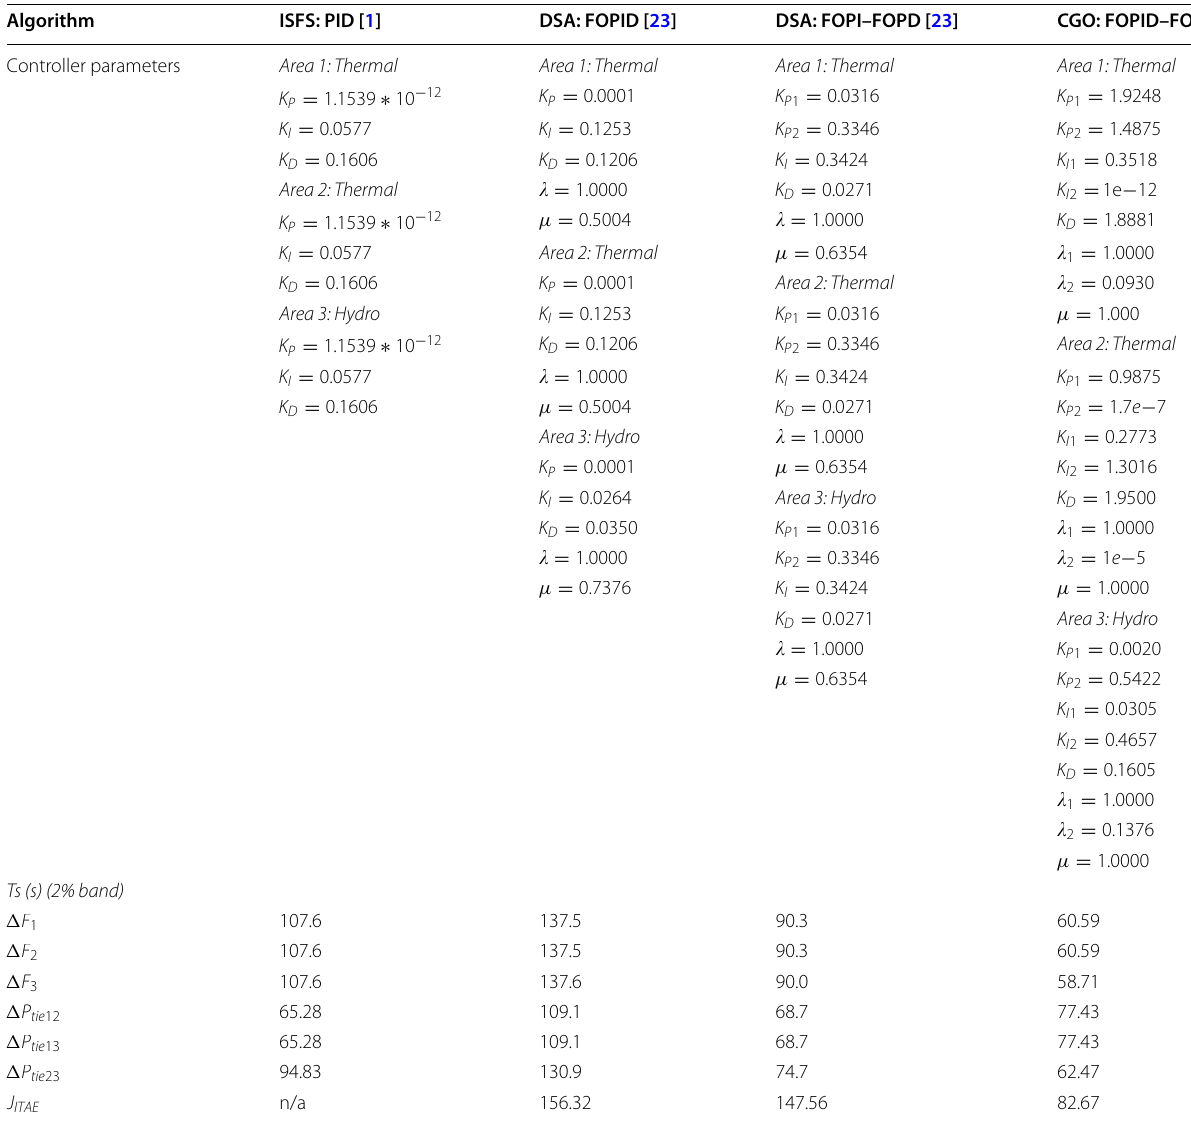
results of Test-system-4 ITAE